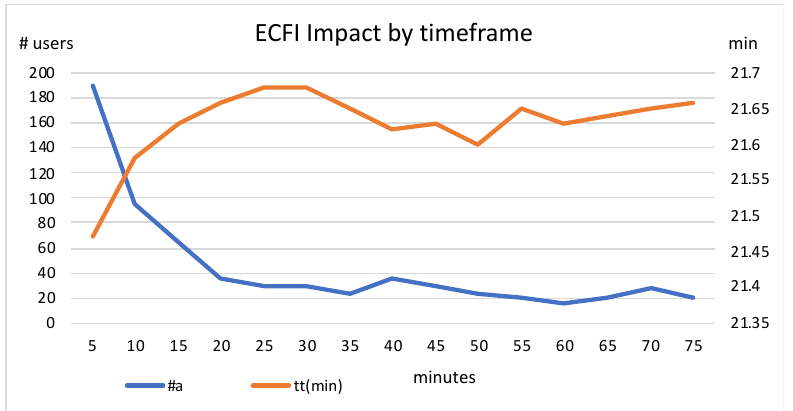
Figure 5. Impact of different prediction timeframes on the behaviour of ExpectedCostFutureImpact (with 𝑅𝑒𝑛𝑡𝐹𝑎𝑖𝑙𝐶𝑜𝑠𝑡 = 3000, 𝑅𝑒𝑡𝑢𝑟𝑛𝐹𝑎𝑖𝑙𝐶𝑜𝑠𝑡 = 2500, 𝐹𝑢𝑡𝑅𝑒𝑛𝑡𝐹𝑎𝑖𝑙𝐶𝑜𝑠𝑡 = 3000, 𝐹𝑢𝑡𝑅𝑒𝑡𝑢𝑟𝑛𝐹𝑎𝑖𝑙𝐶𝑜𝑠𝑡 = 1000, and 𝑓 = 1).